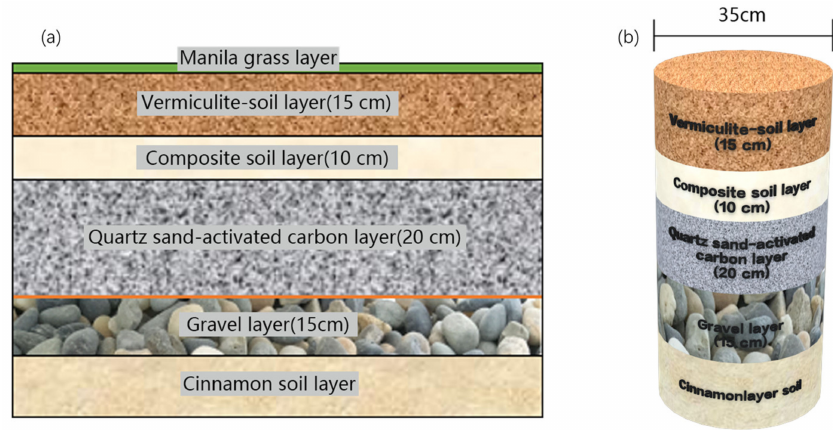
Figure 1. Schematic diagram of sunken greenbelt structure ( a ), and a standard soil column tester ( b ).